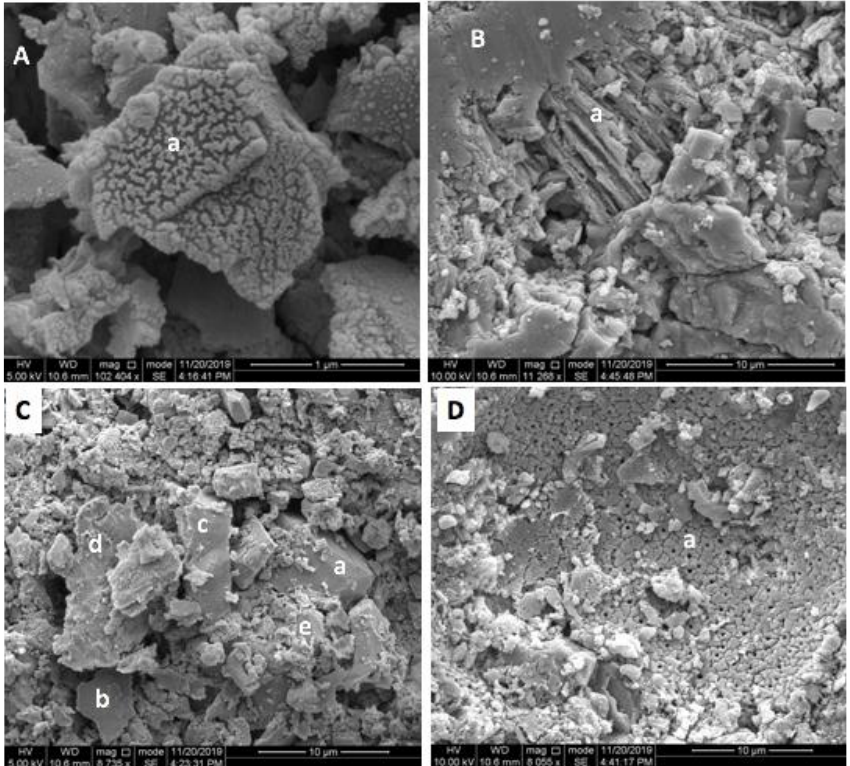
Figure A13. Plate E6: Representative back-scattered SEM images ( A – D ) of the OS-3 bituminous limestone marl sample. Shown are the diverse textural, crystallization, alteration, and fracture features in this rock. See text for detailed